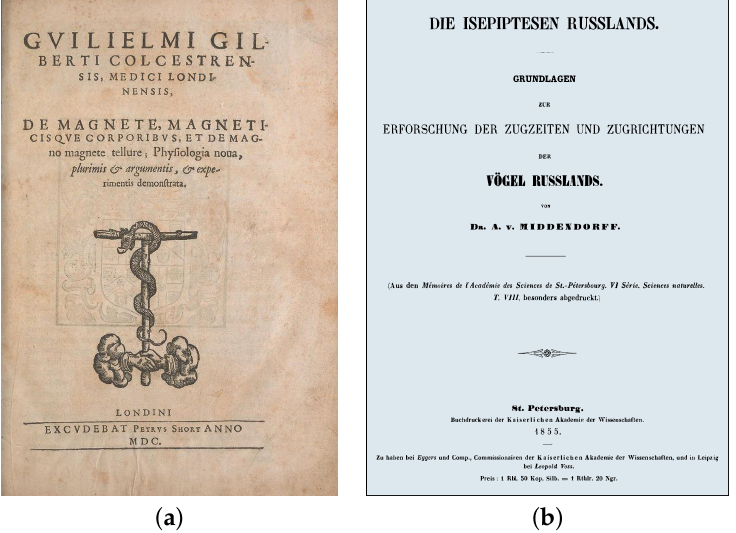
Figure 1. The title pages of ( a ) the first edition of W. Gilbert’s monograph and ( b ) the monograph by A.F. Middendorff with materials from a trip to Siberia.